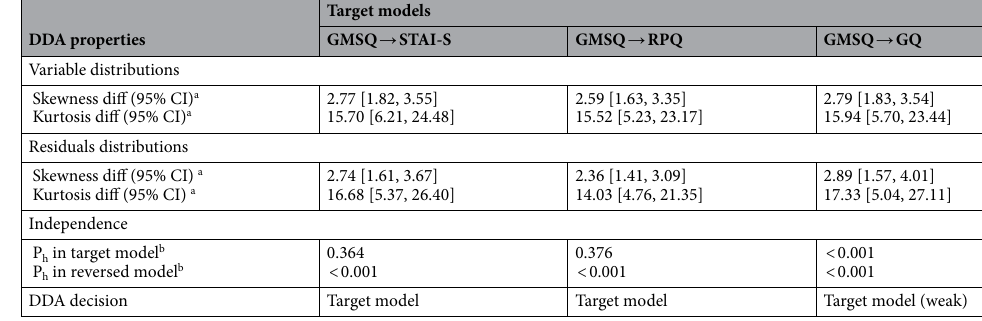
Table 4. Results of direction dependence analysis. Demographic variables (gender, age, current residency, education attainment) were all inputted as covariates for direction dependence analysis (DDA). GMSQ the self- developed Government Management Satisfaction Questionnaire scores, STAI-S State-Anxiety subscale scores of the State Anxiety Inventory, RPQ the Risk Perception Questionnaire scores, GQ the Gratitude Questionnaire scores. a Nonparametric bootstrap approach based on 1000 bootstrap resamples and 95% confidence interval (CI). b P h is p value for Breusch–Pagan heteroscedasticity test.